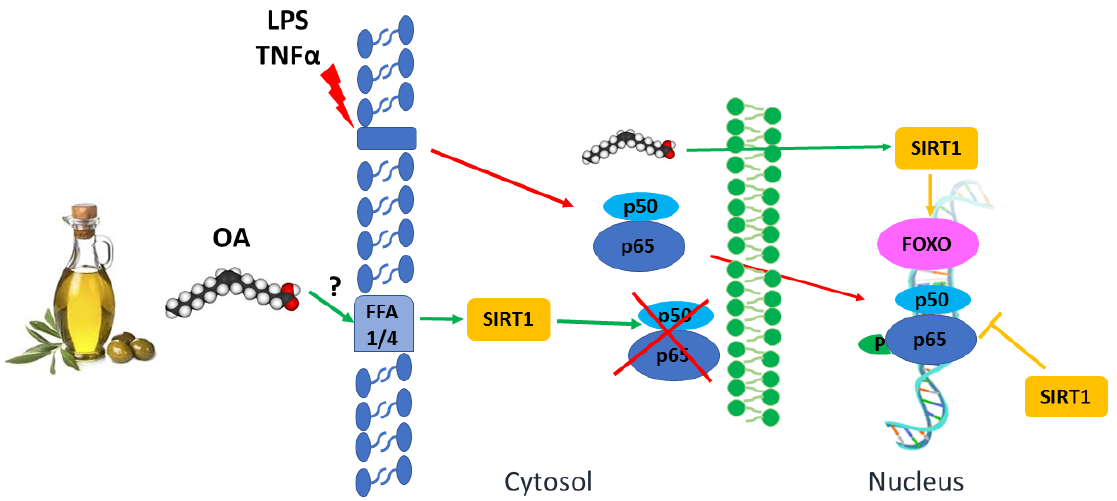
Figure 1. Role of oleic acid (OA) in response to inflammatory stimuli, inhibiting NF- κ B signaling pathway by promoting SIRT1 activity on immune cells. Legends: Blunt arrows ( ⊥ ) indicate inhibition while sharp arrows ( → ) indicate stimulation